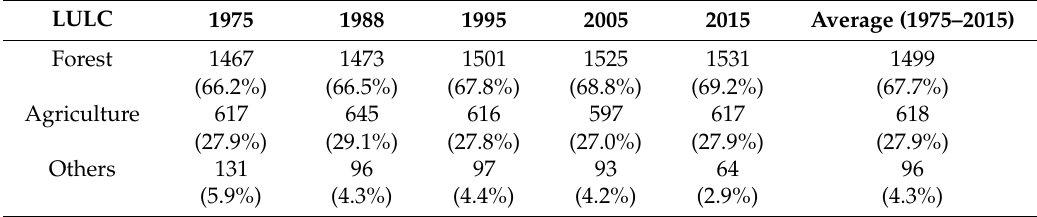
Table 4. LULC in the middle Bagmati catchment between 1975 and 2015 (areas shown in km 2